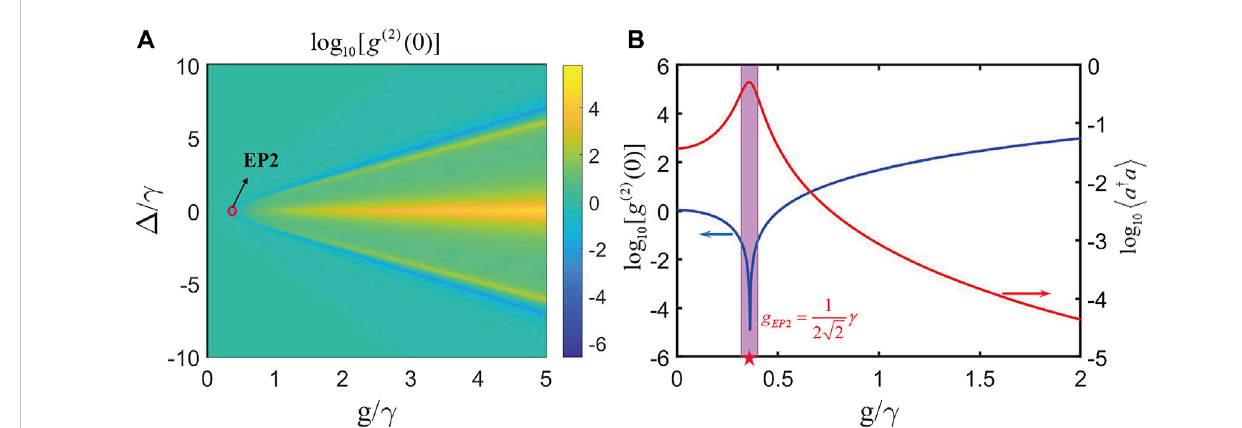
EP2-enhanced strong PB effect in the condition of g 1 (cid:1) g 2 (cid:1) g and Δ c (cid:1) Δ 1 (cid:1) Δ 2 (cid:1) Δ . (A) Logarithmic plots of g ( 2 ) ( 0 ) as functions of normalized detuning Δ / γ andthesamecouplingstrength g / γ .TheredcircleshowsthepositionofEP2,wheretheextremelysmall g ( 2 ) ( 0 ) canbeachieved. (B) Plotsof g ( 2 ) ( 0 ) (see blue curves) and I c (see red curves) versus the coupling strength g / γ . The pink dashed line indicates the position of EP2. We choose Δ c (cid:1) 0 in panel (B) .